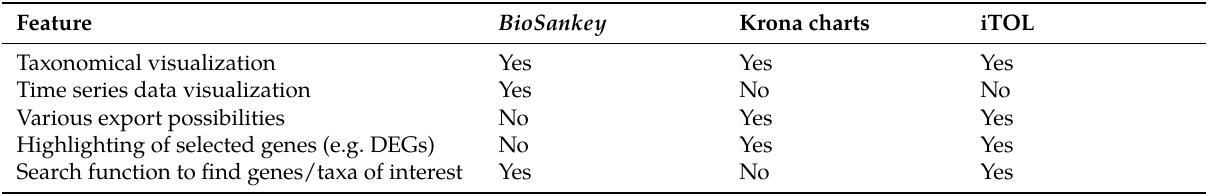
Table 1: Comparison of the three tools BioSankey , Krona and